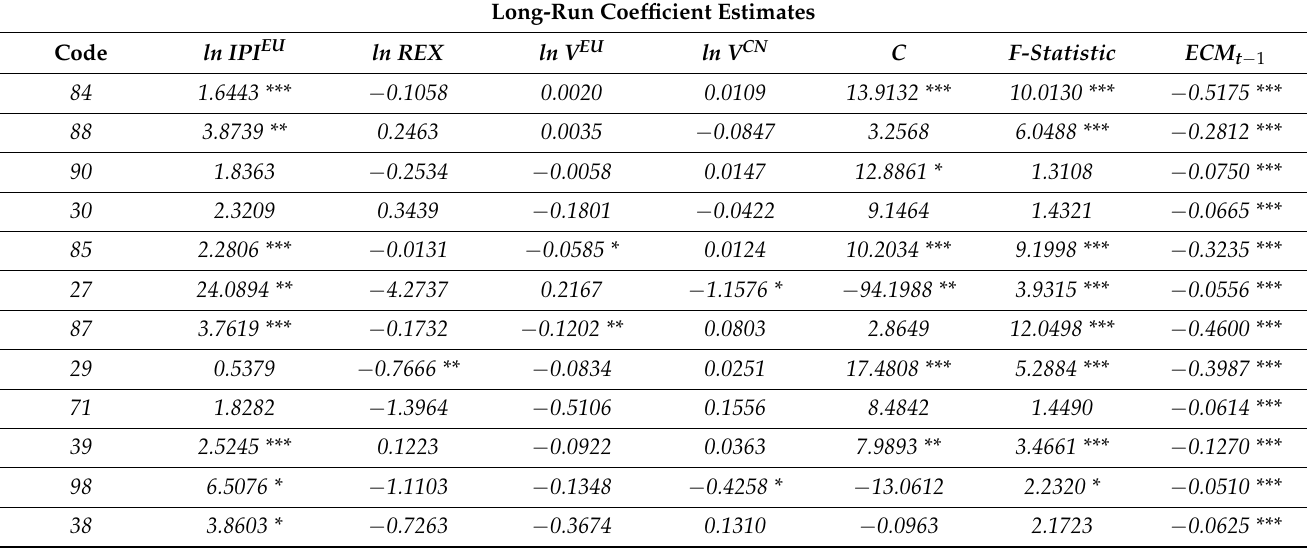
Table 4. Long-run coefficient estimates of US exports to the EU with third country effects using the linear ARDL model